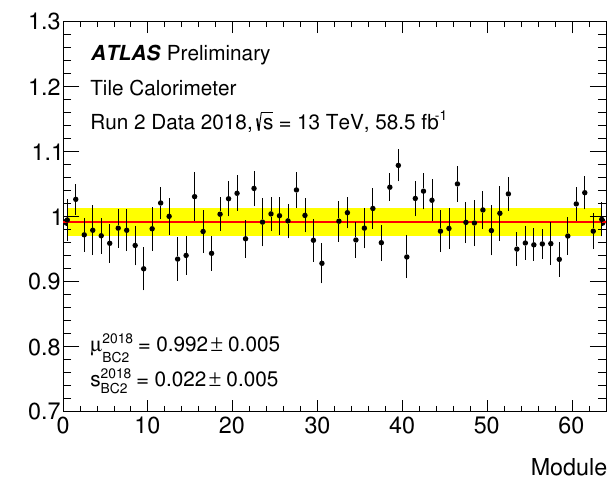
Figure 6. The double ratio R as a function of the TileCal module for the cell type BC2 as obtained with muons from W decay. The error bars represent the statistical uncertainty. The red line indicates the mean relative response ( µ ) and s (yellow band) displays additional uncertainty as determined from Gaussian likelihood fit performed on the R values for this cell type